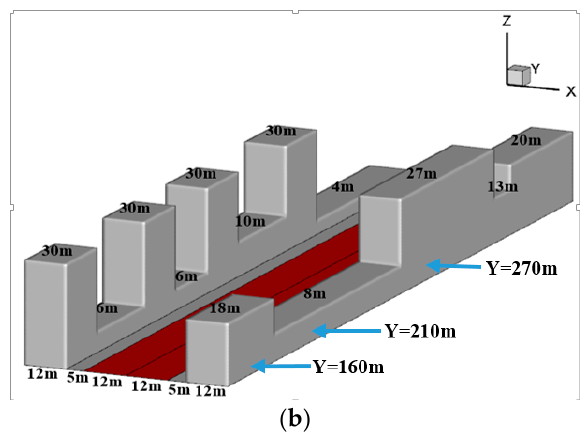
Figure 2. Street canyon model ( a ) computing domain model and the boundary conditions; ( b ) building geometric structure.